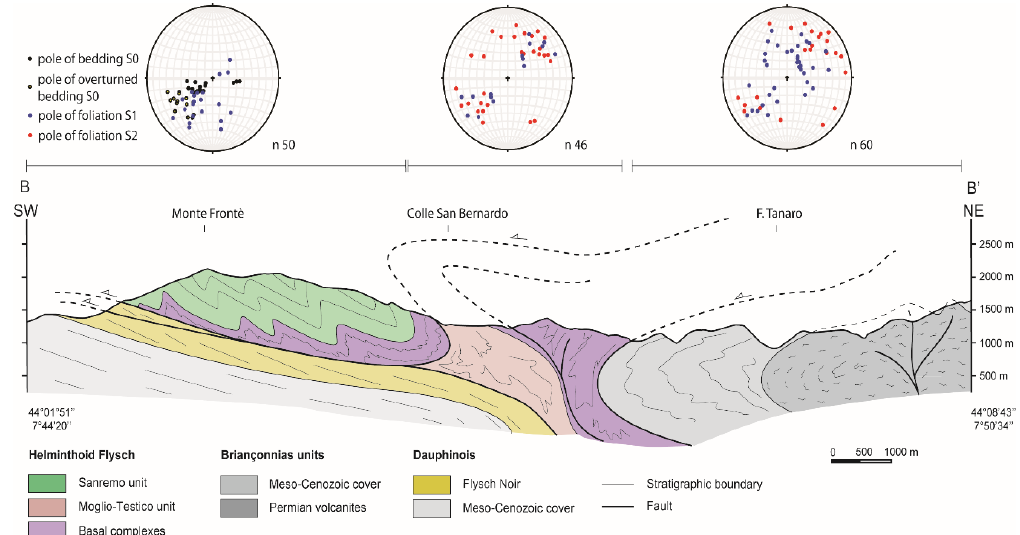
Figure 6. Cross-section B-B’. See Figure 3 for the map location. Lower hemisphere, equal area stereonets of representative foliation data. The section has been divided in three sectors internally homogeneous.